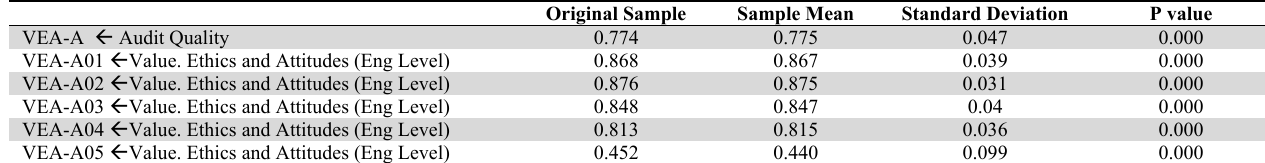
The Manifestation of Attributes of Values, Ethics and Attitude for Engagement (Auditor) Level